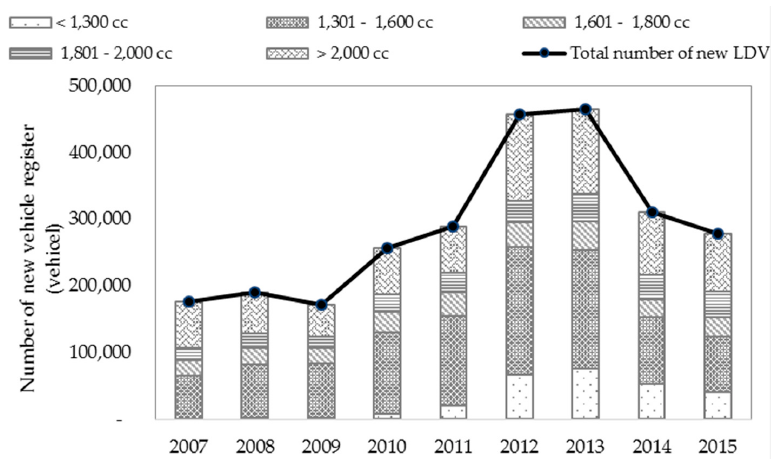
Figure 6. Number of new light duty vehicles registered, classified by engine size.